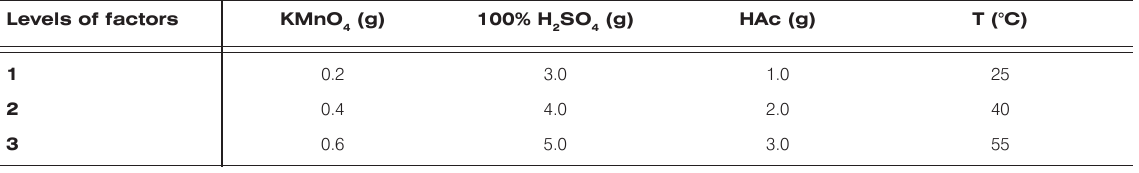
Table 1. Influence factors and experiment dosages of reactants a . Levels of